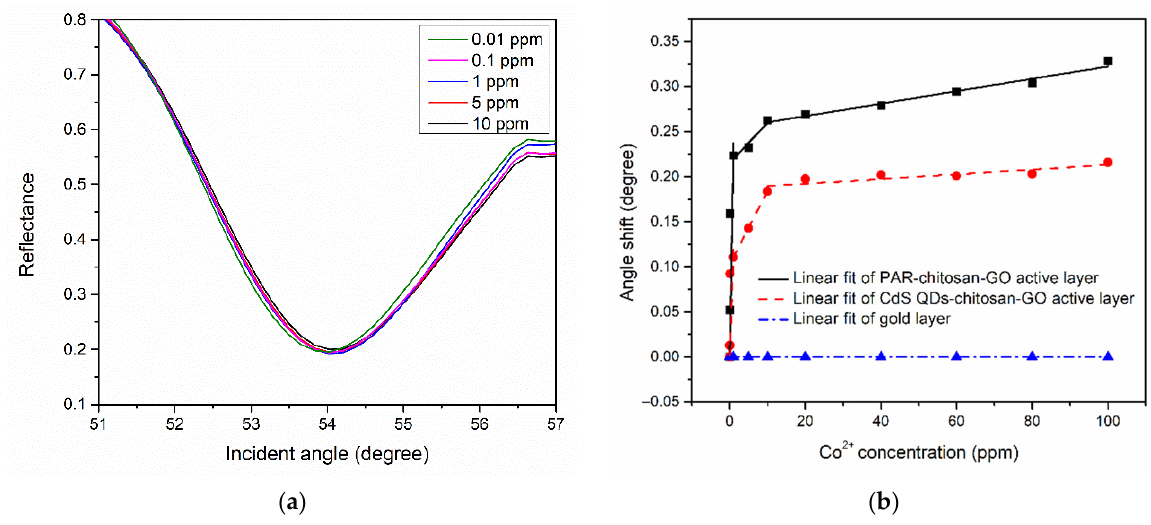
Figure 4. ( a ) SPR response of thin films in contact with Co 2+ at 0.01–10 ppm concentration, and ( b ) the comparison of the linear regression analysis for various concentration of Co 2+ in contact with gold layer and modified gold layer thin films.